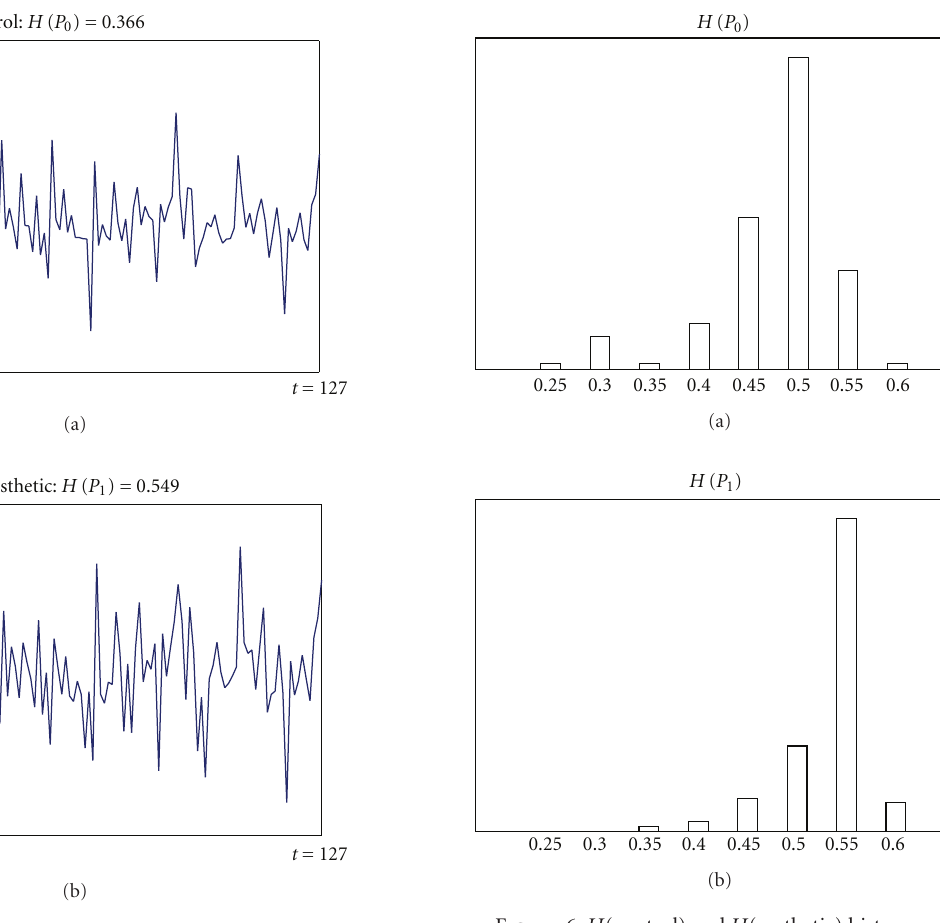
Figure 5: ξ (cid:9) ( t ) for Trial 56. Table 2: Descriptive statistics of out-of-sample trials 101–200.